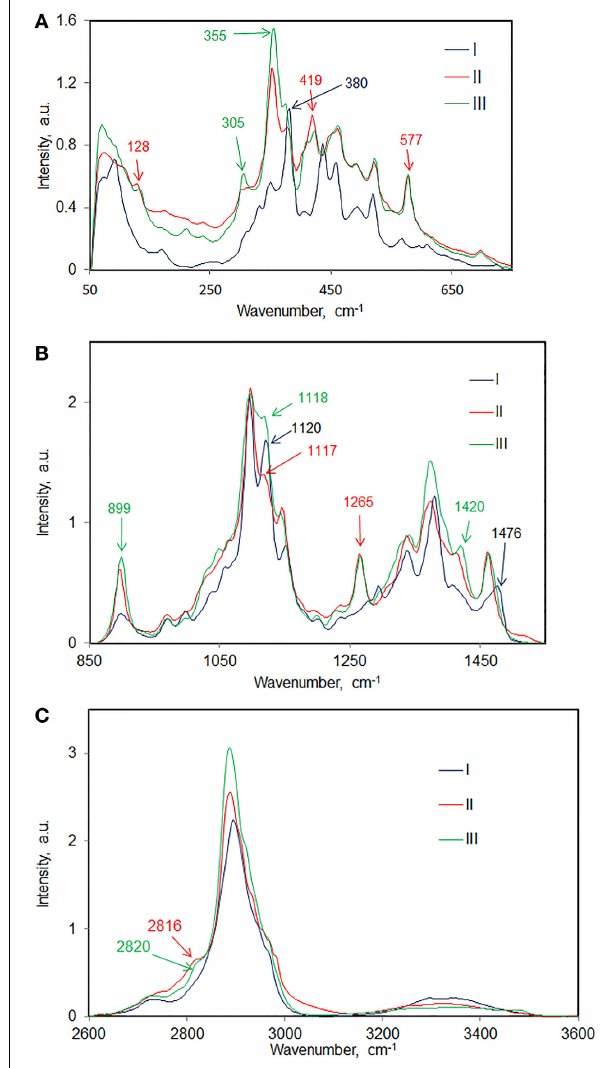
FIGURE 7 | Cellulose I, cellulose II, and cellulose III I compared in various spectral regions; (A) 50–750cm − 1 , (B) 850–1550cm − 1 , (C) 2600–3600cm − 1 .